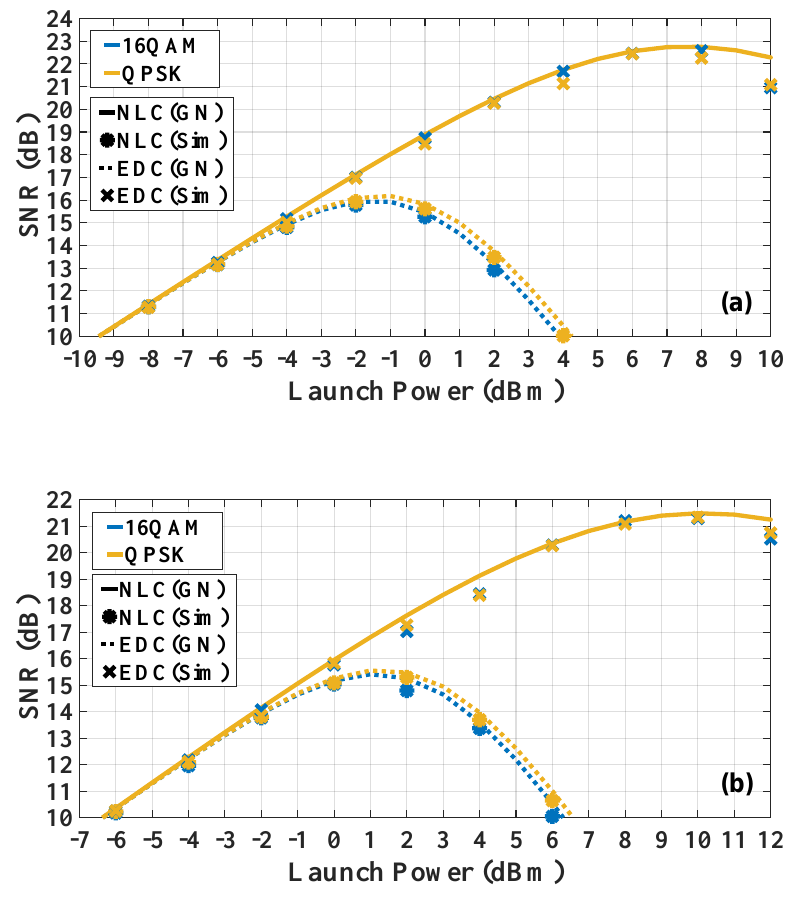
Figure 3. The SNR with different launch power in Nyquist-spaced 5-channel systems with transmis- sion symbol rates of 32 GBd in ( a ), and of 64 GBd in ( b